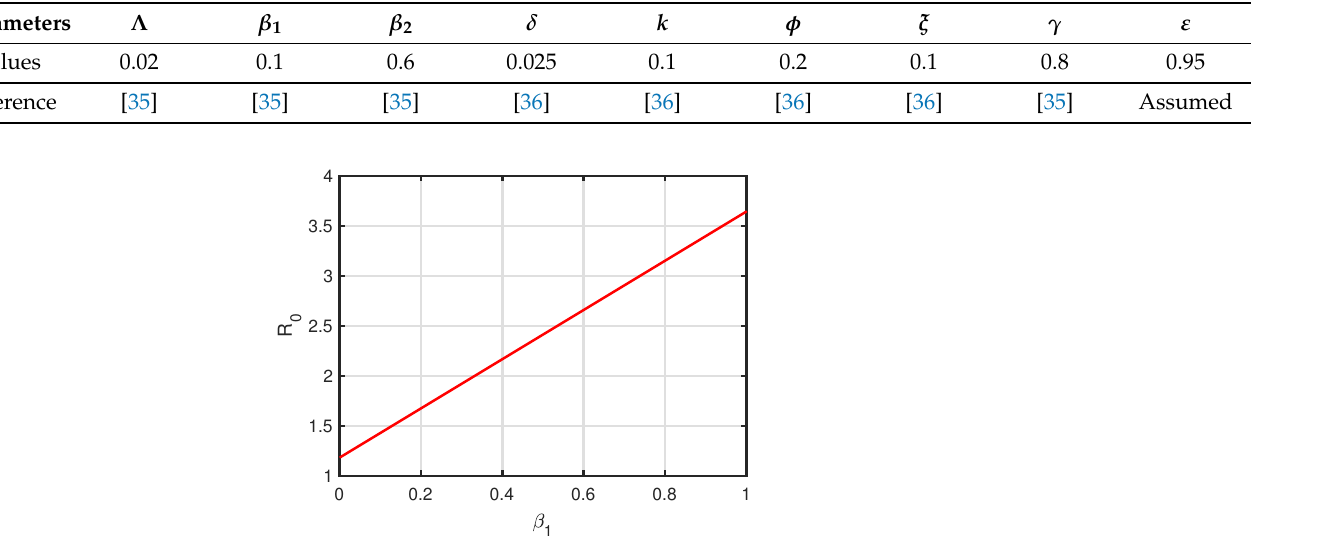
Figure 7. Variation of R 0 of system (3) with respect to β 1 while values of other parameters are taken from Table